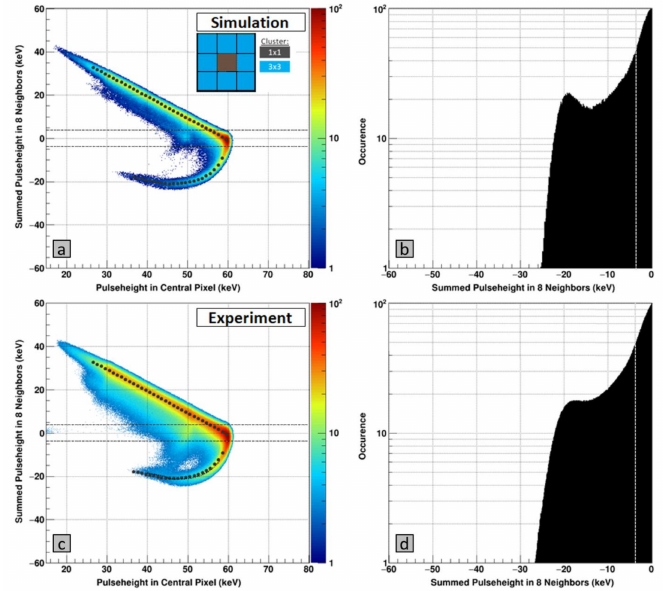
Figure 7. ( left ) Correlation plots of monochromatic 60 keV photons showing the sum of the signals in the 8 adjacent pixels (y-axis) as function of the signal in the central pixel (x-axis) of a 3 × 3 cluster. The horizontal black dotted lines represent the selection criteria of ± 3 × the noise of the eight neighboring pixels. ( a ) Correlation plot generated from a simulated dataset using the following parameters: τ e = 120.0 ns, µ e = 4000 cm 2 /(V · s), τ h = 2.5 ns, µ h = 200 cm 2 /(V · s). The gray points indicate the fitted value of the summed pulse height in the eight neighboring pixels. ( c ) Correlation plot generated from experimental data. The gray points indicate the fitted value of the summed pulse height in the eight neighboring pixels for the simulated dataset. ( right ) Projection of the negative signal tail of the correlation plots. The gray vertical line indicates –3 × the noise of the eight neighboring pixels, i.e., all events left of this line are considered as crater hits ( b ) Simulation and ( d ) Experimental data.